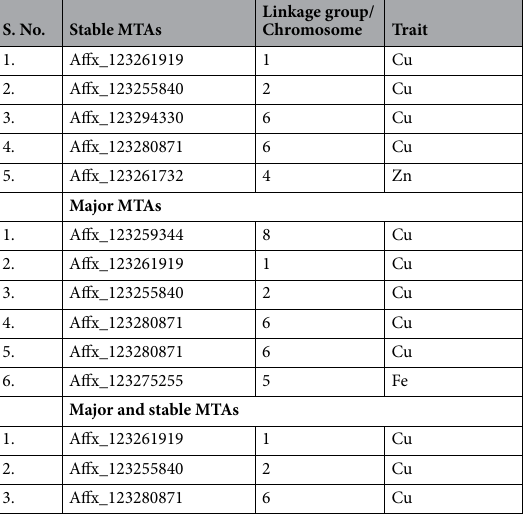
Table 6. Details of the stable, major, and both major & stable marker-trait associations (MTAs) identified during the present study for seed Cu, Zn, and Fe concentration.